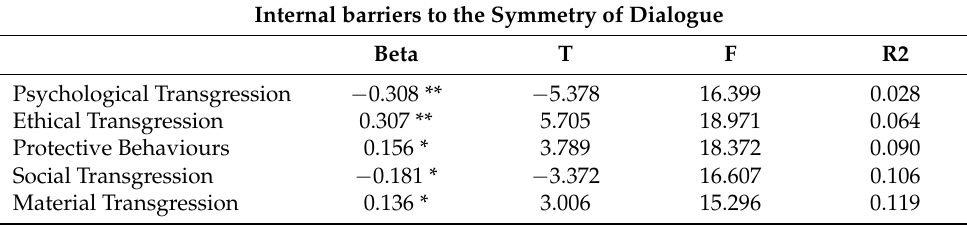
Table 5. Regression analysis of the transgression dimensions which explain Iinternal barriers to the Ssymmetry of dialogues (N =